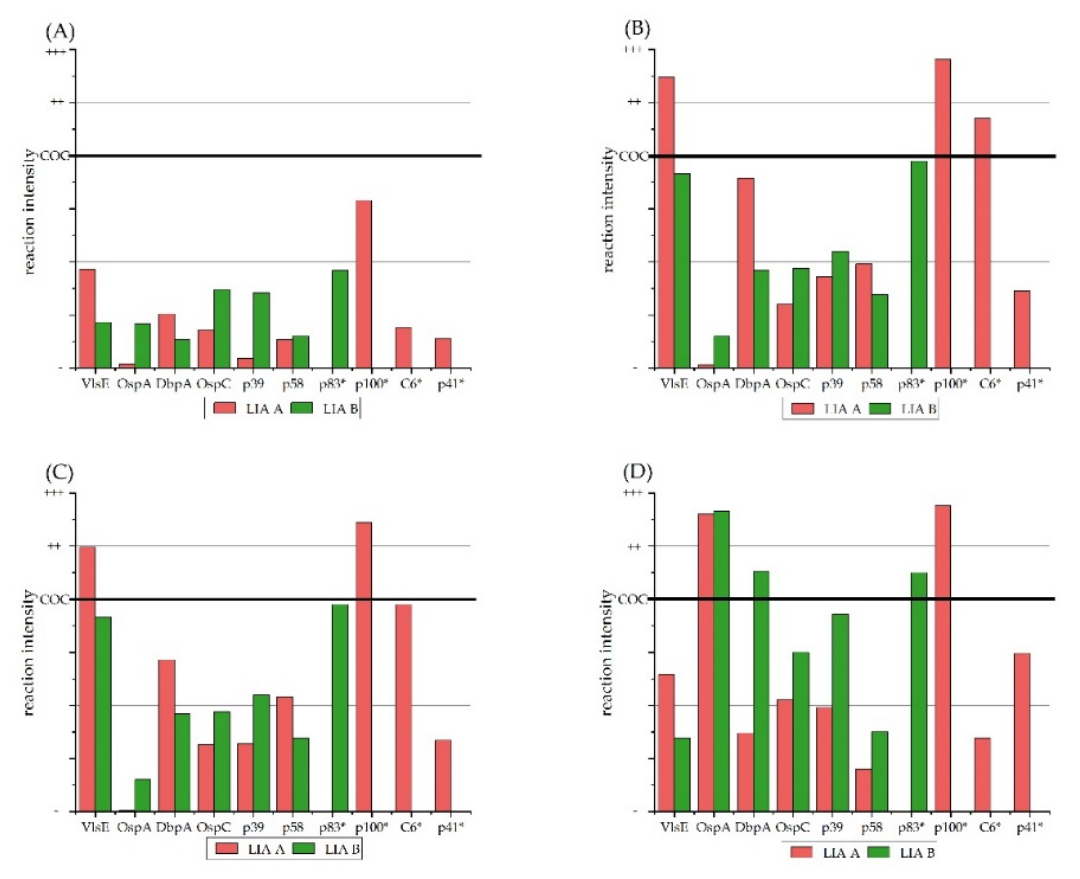
Figure 2. Degree of antigen-antibody reactions on LIA A and LIA B resulting from tests with equine serum samples. Ranking from reaction as “ − ”, less than the cut-off control COC; “+”, equal to the COC; “++”, strong; and “+++”, very strong reactions. Antigens marked with * are unique for the respective LIA. Degree of antigen-antibody reactions of sera ( A ) from group “negative”; ( B ) from group “positive”; ( C ) from group “equivocal”; ( D ), from “control sera—vaccinated”. COC, cut-off control; VlsE, variable major protein-like sequence expressed; OspA, outer surface Protein A; DbpA, decorin binding protein A; OspC, outer surface protein C; BmpA, borrelia membrane protein A; p, protein; C 6 , C 6